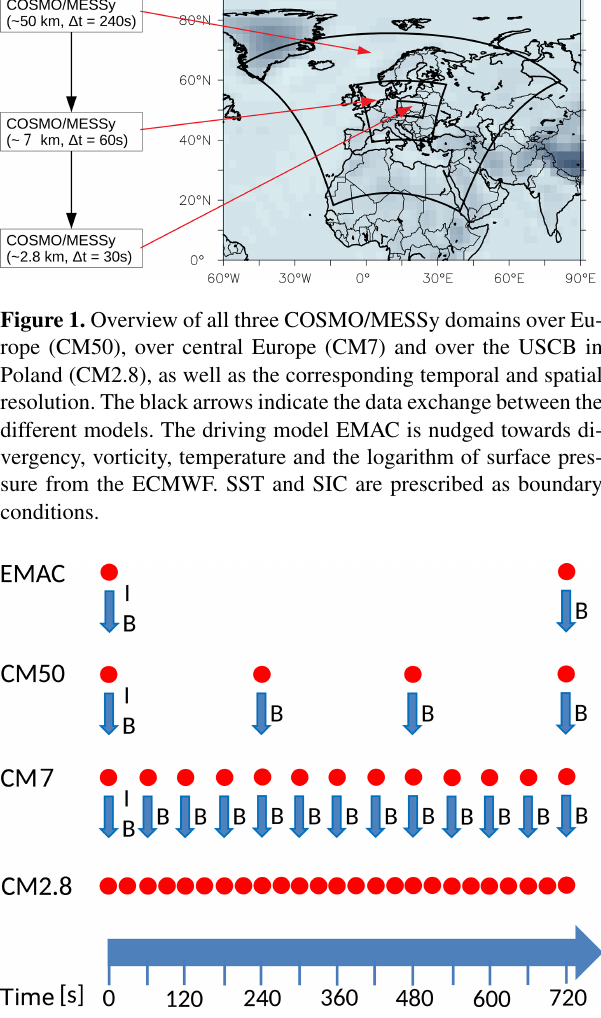
Figure 2. The illustration shows the initial and boundary data exchange between EMAC and the different COSMO/MESSy in- stances. The blue arrows symbolize the data exchange between the different model instances. B stands for boundary data and I for ini- tial data. The red circles visualize the specific time steps of data